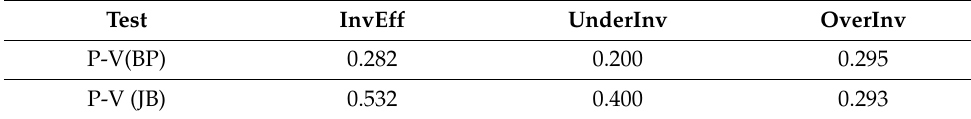
Table 4. Breusch–Pagan and Jarque–Bera test of the dependent variables.